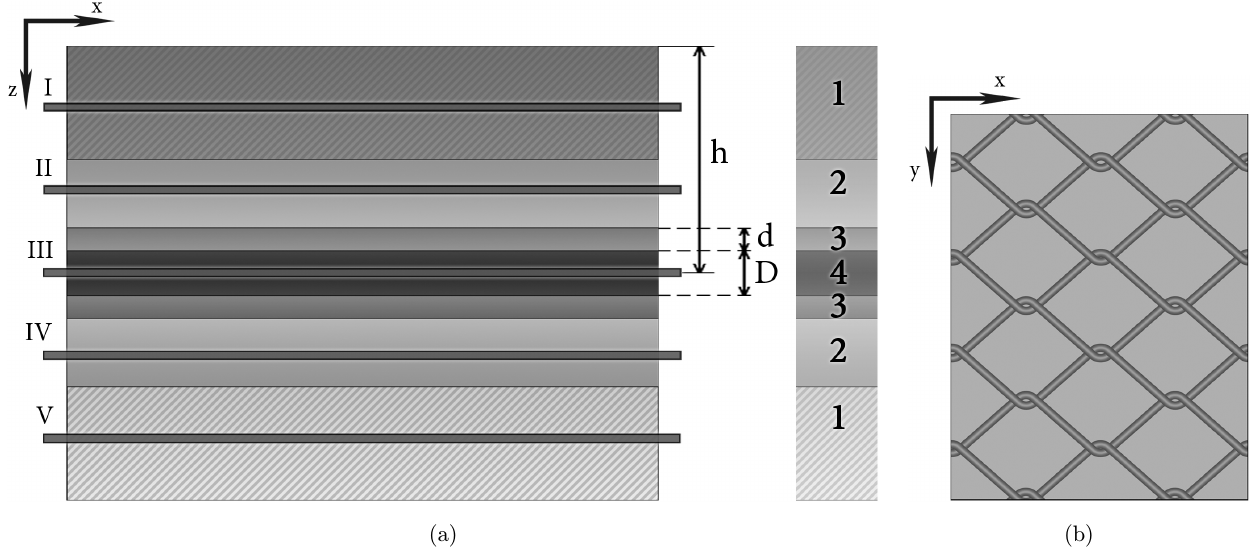
Fig. 3. Topology of tissue with mesh implant: (a) normal tissue (1) and implant ¯ber (4) surrounded by necrosis layer (3) in encapsulation area (2), (b) mesh implant cross-section on the depth h, and (c) confocal microscopy frames for 3D image